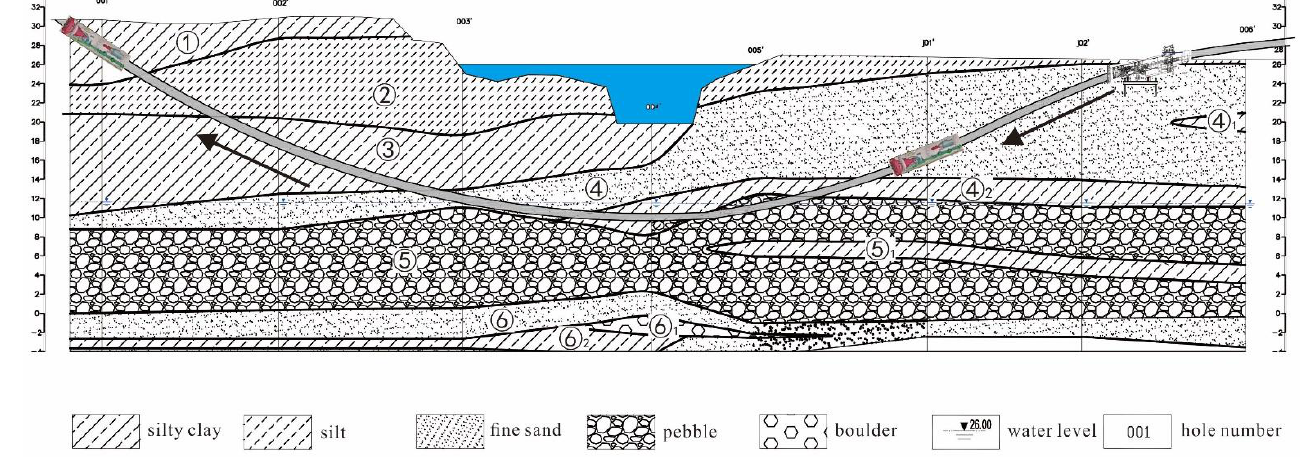
Figure 3. Geological profile of this project. Table 2. Summary of soil properties.